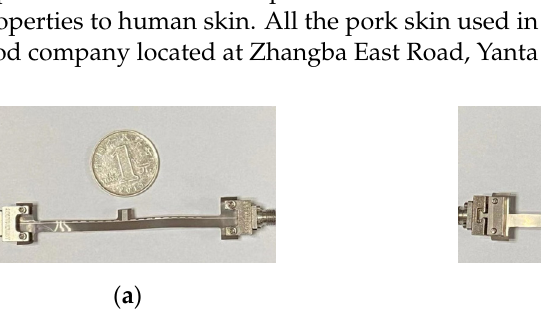
Figure 10. ( a ) Top view of sensor; ( b ) Bottom view of sensor.